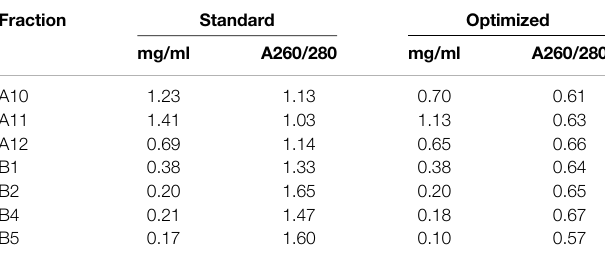
TABLE 2 | Assessing the purity of the standard and optimized puri fi cation methods. Concentration (mg/ml) and the ratio of absorbance measured at 260 – 280 nm (A260/280) of fractions following analytical SEC. Fractions correspond to those labeled in Figure 5